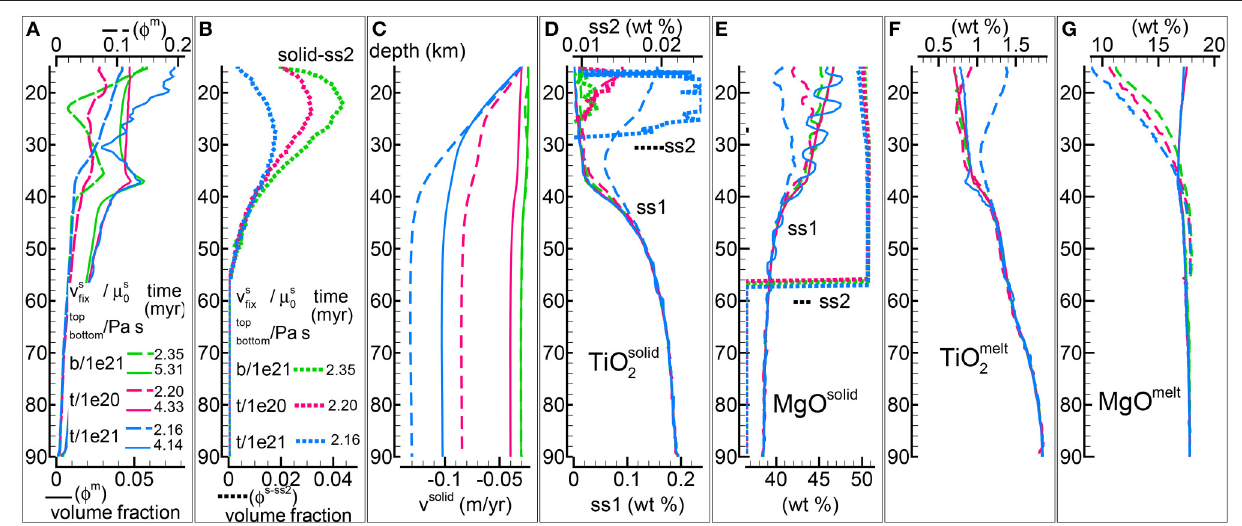
FIGURE 7 | DFM model assuming fixed velocity of the solid ( − 0.03 m/yr) at the top (t) or the bottom (b). Fixed velocity at the bottom with µ s 0 = 1 e 21 Pa s (green lines, same as in Figures 3 , 5 , 6 ), fixed velocity at the top with µ s 0 = 1 e 20 Pa s (magenta lines), fixed velocity at the top with µ s 0 = 1 e 21 Pa s (blue lines) Solid viscosity model: µ s = µ s 0 , permeability constant C = 1e9 m − 2 . (A) Melt volume fraction vs. depth at 2 different times (solid and dashed lines). Earliest time is approximately defined by the largest amount of melt reaching the top side. Dotted line is the volume fraction of solid in sub-sys 2. (B) Velocity of the solid matrix. (C–F) Compositional variations in solid and melt (wt %). (C) TiO 2 in the residual solid (ss1) and solid in sub-sys 2 (ss2, dotted lines). (D) MgO in the residual solid (ss1) and solid in sub-sys 2 (ss2, dotted lines). (E) TiO 2 in melt. (F) MgO in melt. Data files PHASE3B.YRC1.DAT (bottom fixed, µ s 0 = 1 e 21 Pa s), PHASE3B-P.YRC18.DAT (top fixed, µ s PHASE3B-P.YRC19.DAT (top fixed, µ s 0 = 1 e 21 Pa s) are included in the zip file 0 = 1 e 20 Pa s), max-front2-data.zip . See the Supplementary Material for additional